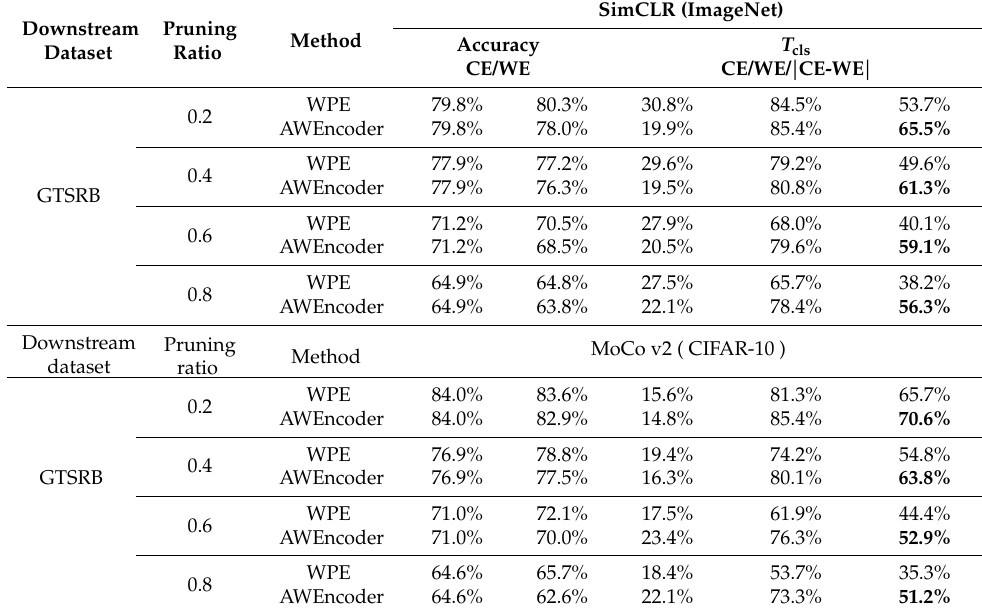
Table 7. Robustness in black-box verification against